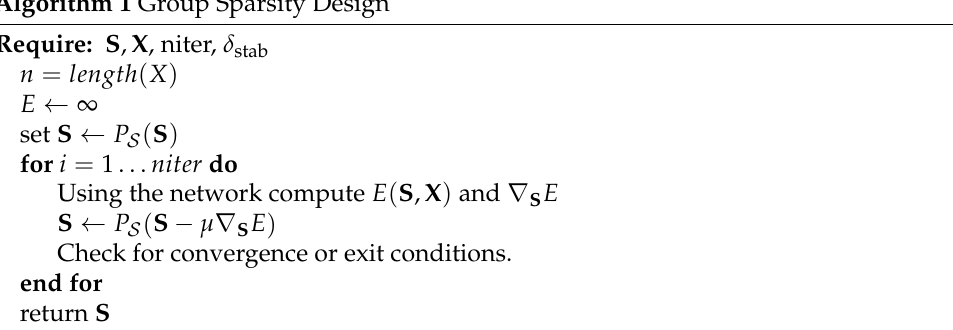
Algorithm 1 Group Sparsity